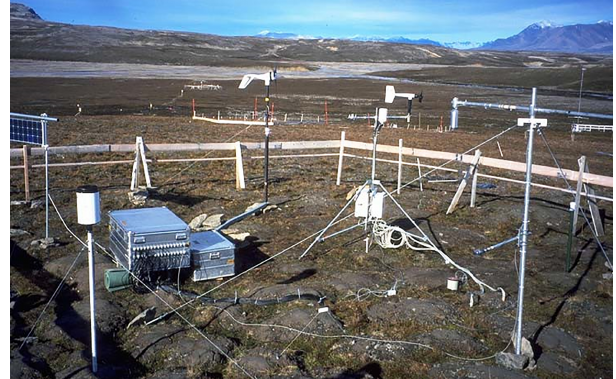
Figure C1. Bayelva climate station setup, September 1998– August 2009, (78.92094 ◦ N, 11.83334 ◦ E). Picture taken after in- stallation in August 1998.